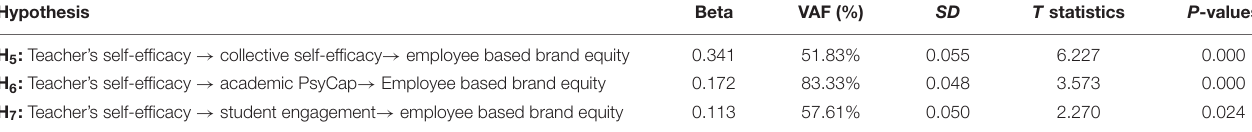
TABLE 6 | Indirect effects.